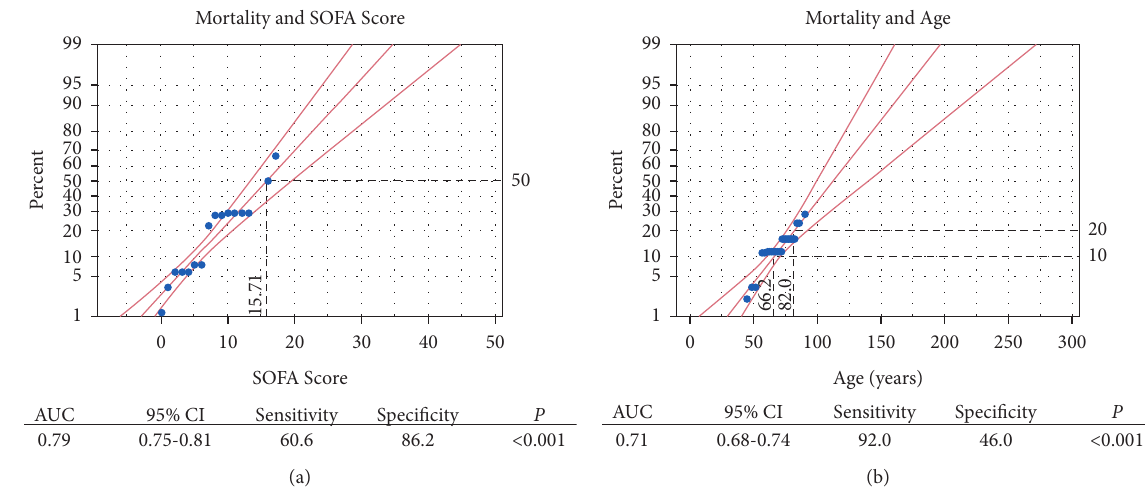
Figure 2: Probit and AUROC analysis for EGS patients’ outcome of mortality. AUC: area under the ROC curve; CI: confidence interval; EGS: emergency general surgery; ROC: receiver operating characteristic; and SOFA: Sequential Organ Failure